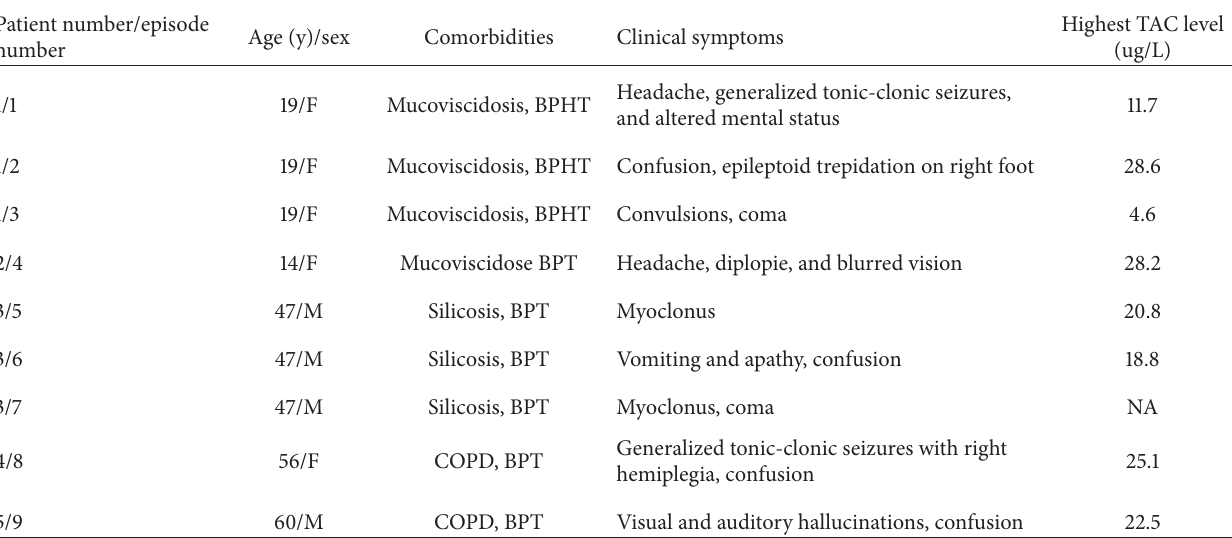
Table 1: Clinical characteristics of 9 episodes of TAC-E of the 5